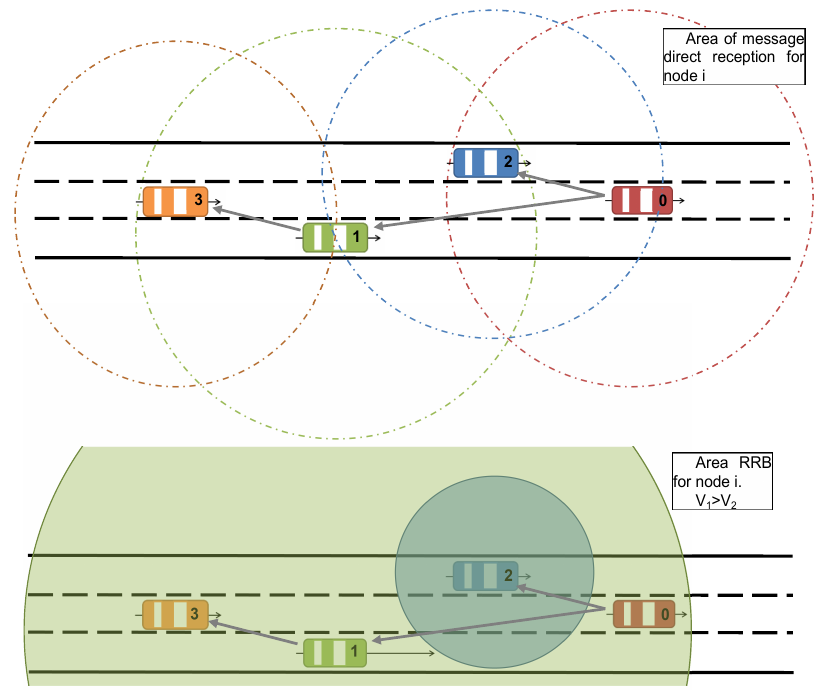
Figure 2. Graphical description of the “range of rebroadcasting” (RRB)